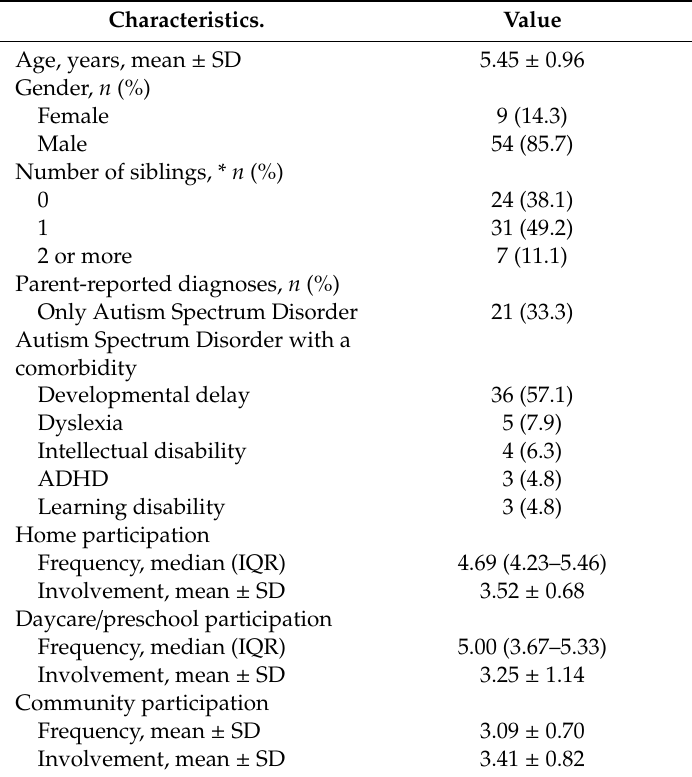
Table 1. Characteristics of children in the study.